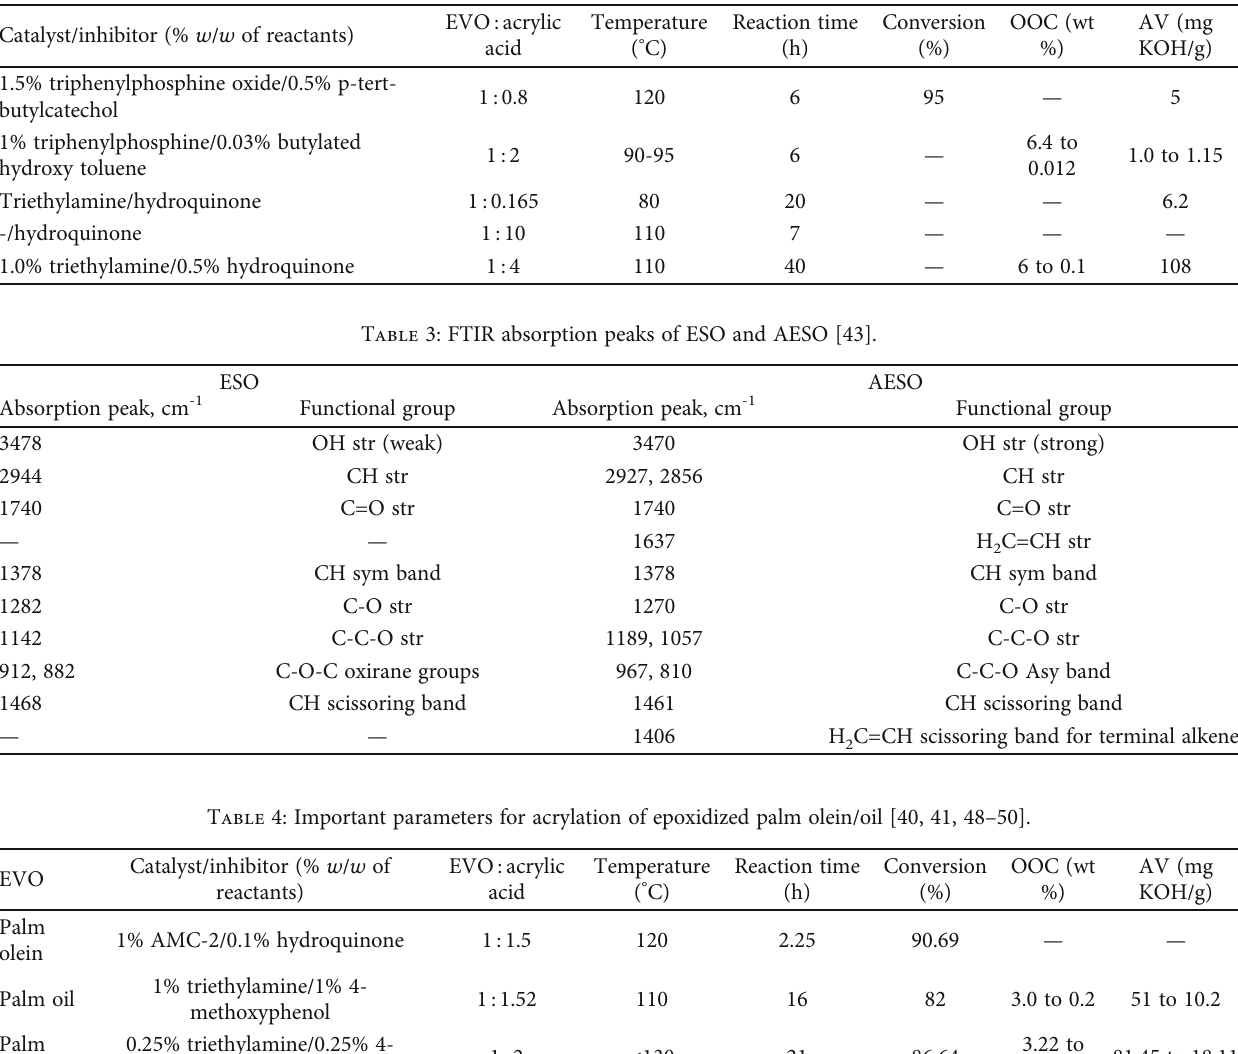
Table 2: Important parameters for acrylation of epoxidized soybean oil [1, 4, 45 – 47]. Catalyst/inhibitor (% w / w of reactants)